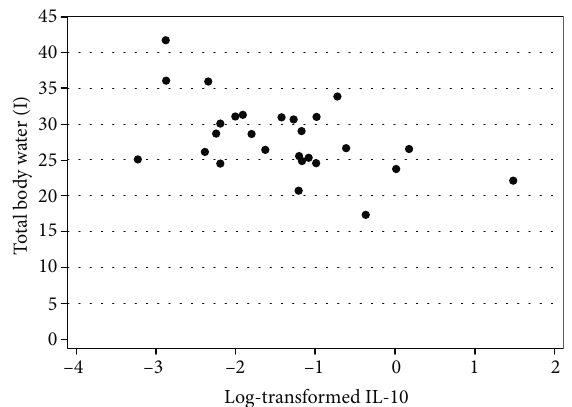
Figure 1: The association between total body water and IL-10 levels (log-transformed for improved presentation) in study participants with anorexia